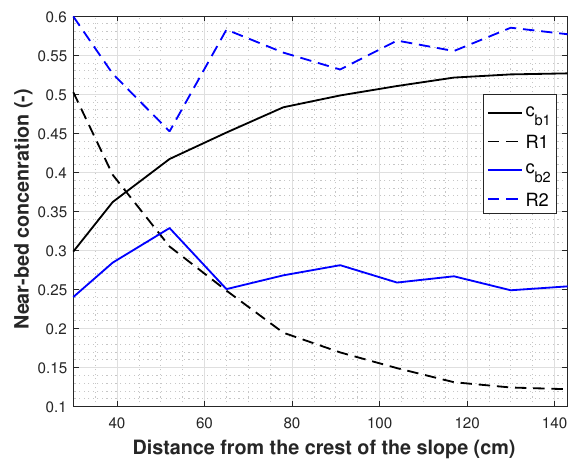
Figure 7. Two definitions of near-bed concentration c b and the corresponding reduction factors R ; c b 1 is the concentration of the first cell above the bed, while c b 2 is the average concentration in the inner